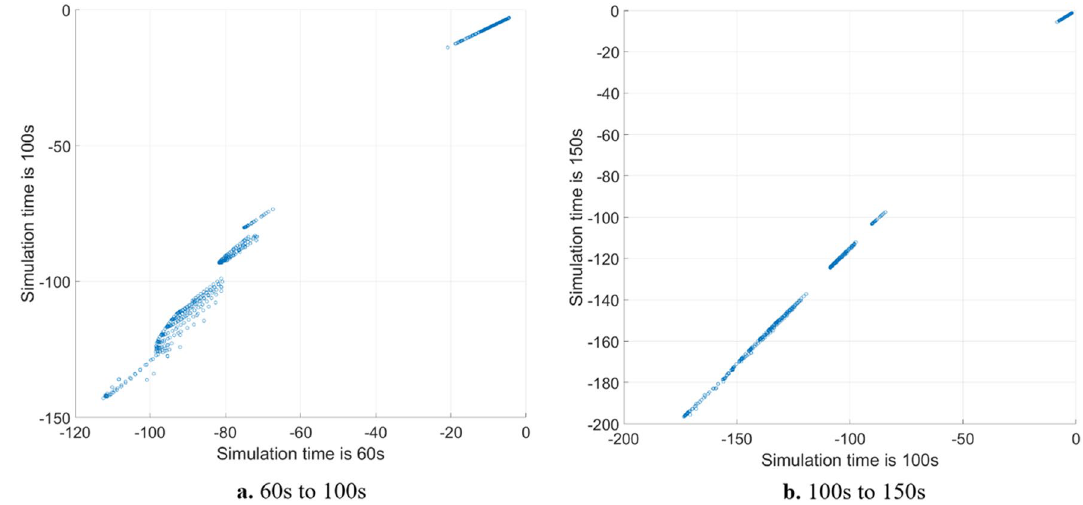
Figure 4. Mapping relation of sum of Lyapunov exponents at different